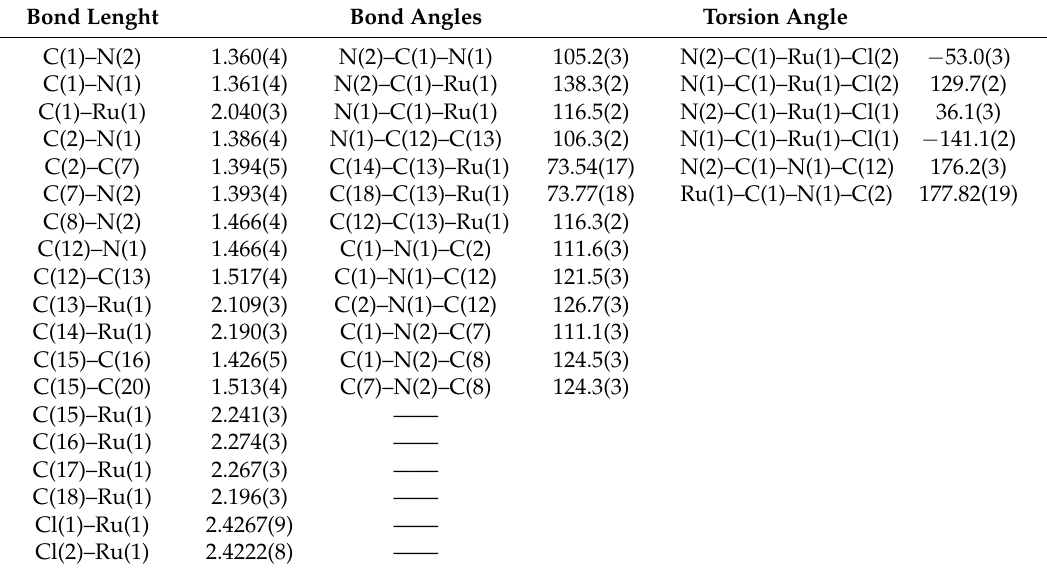
Table 2. Selected bond lengths (Å), angles ( ◦ ) and torsion angles ( ◦ ) for compound 2b